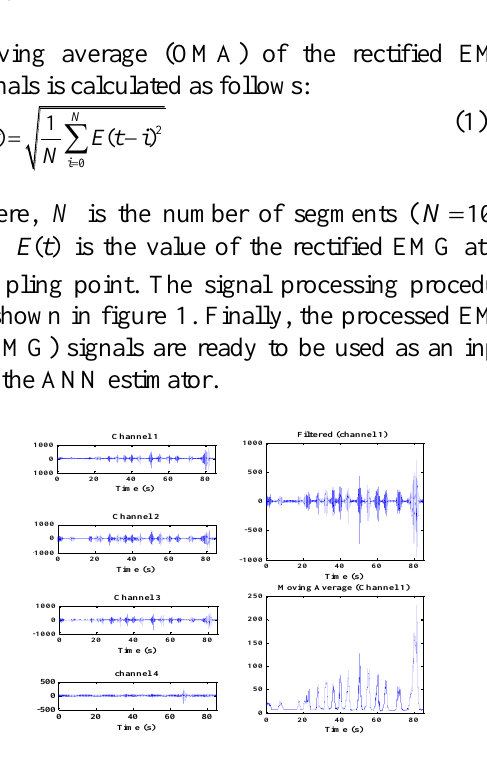
Figure 1. EMG process for neural network estimation.